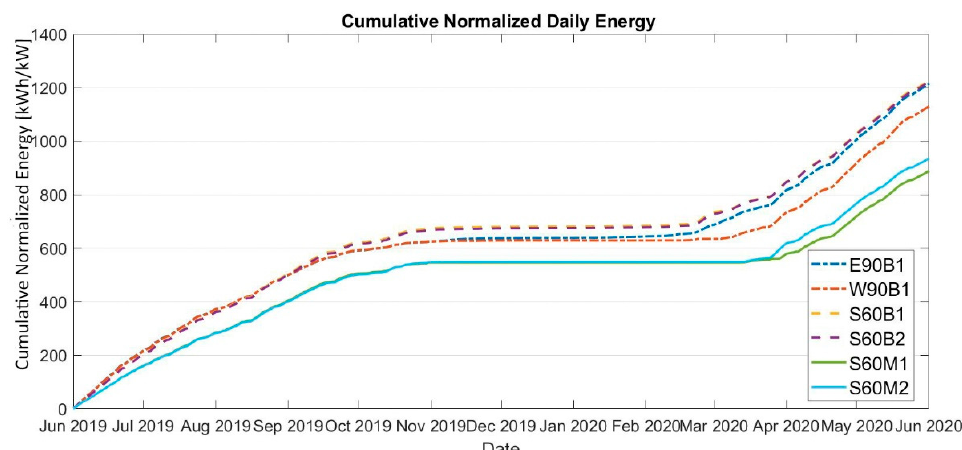
Figure 13. One year of cumulative energy production data are shown for each PV module included in